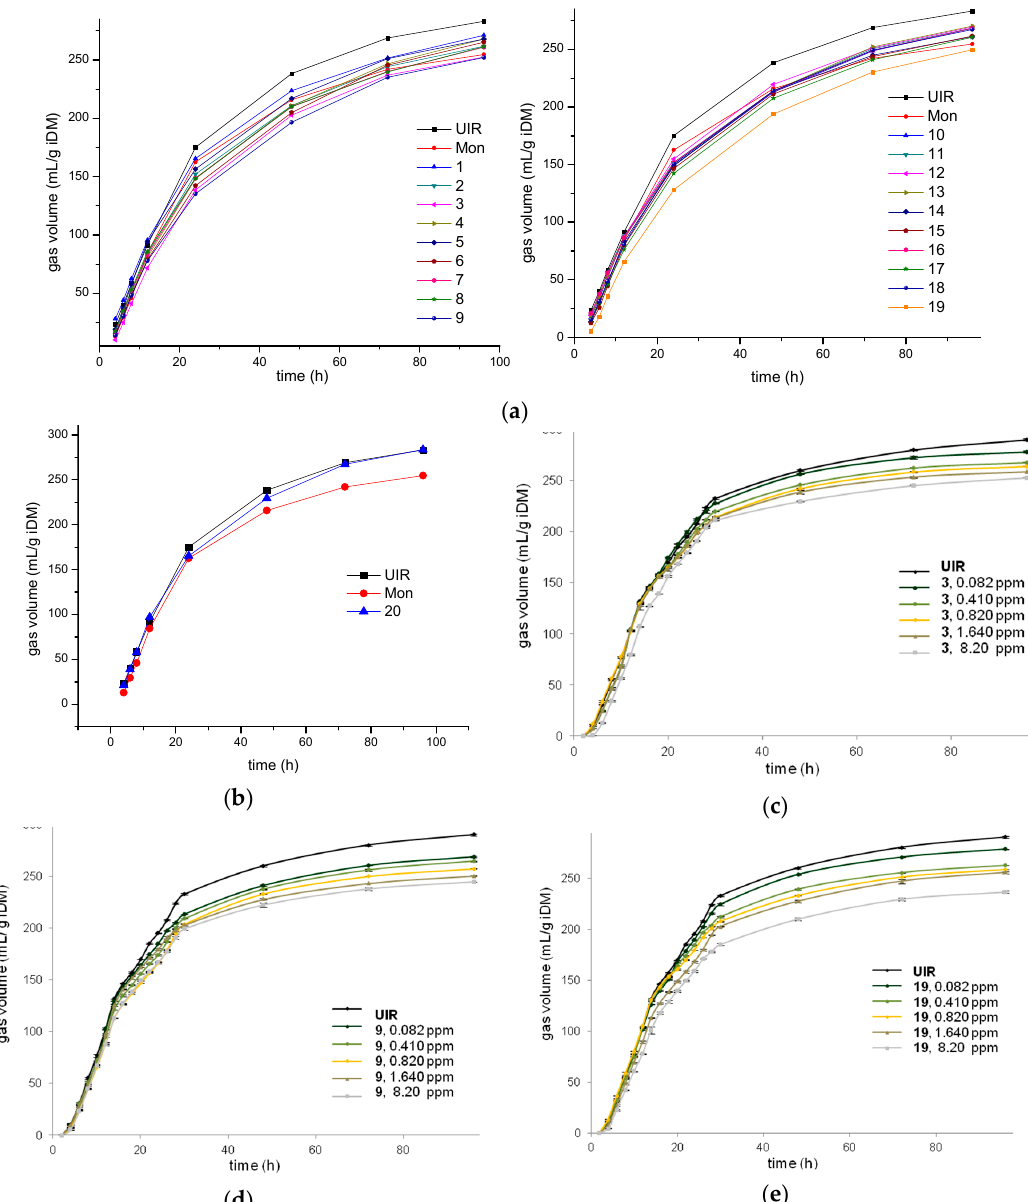
Figure 3. The rumen dynamics of total gas production with or without the studied N -oxides at 0.82 ppm ( a ; left: phenazine dioxide, quinoxaline dioxide, triazine 4-oxide, and benzofuroxan derivatives; right: indazole 1-oxide, benzimidazole dioxide, and furoxan derivatives). The error bars were omitted in order to simplify the presentation. The behavior of the selected negative control 20 at 0.82 ppm ( b ), the dose–response curves of gas production for quinoxaline dioxide 3 ( c ), benzofuroxan 9 ( d ) and furoxan 19 ( e ).